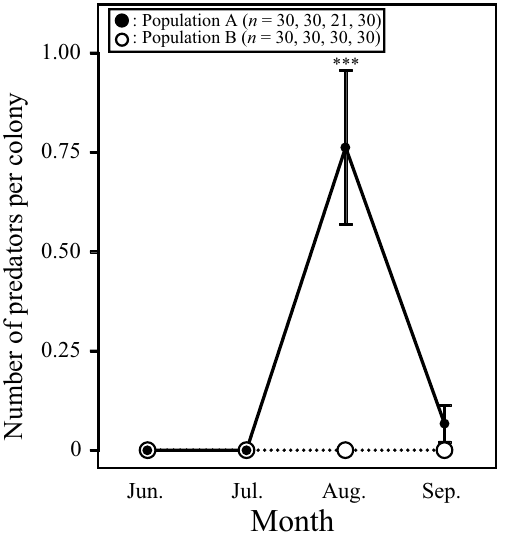
Figure 2. Temporal and between-population variation in the number of predators per aphid colony. The number of predators represents the sum of the numbers of A. ignipicta and T. hamada larvae. Error bars denote s.e. Asterisks indicate a significant difference between populations (*** P <